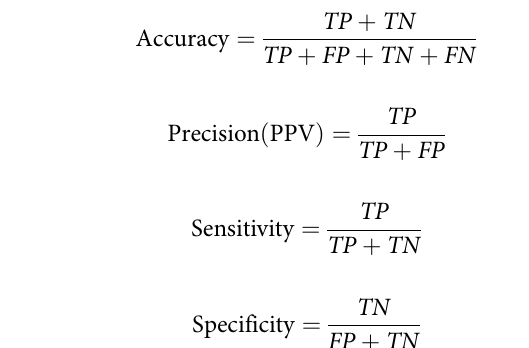
The tabulated confusion matrix across all 30 repetitions of 10-folds is presented in Table 3.